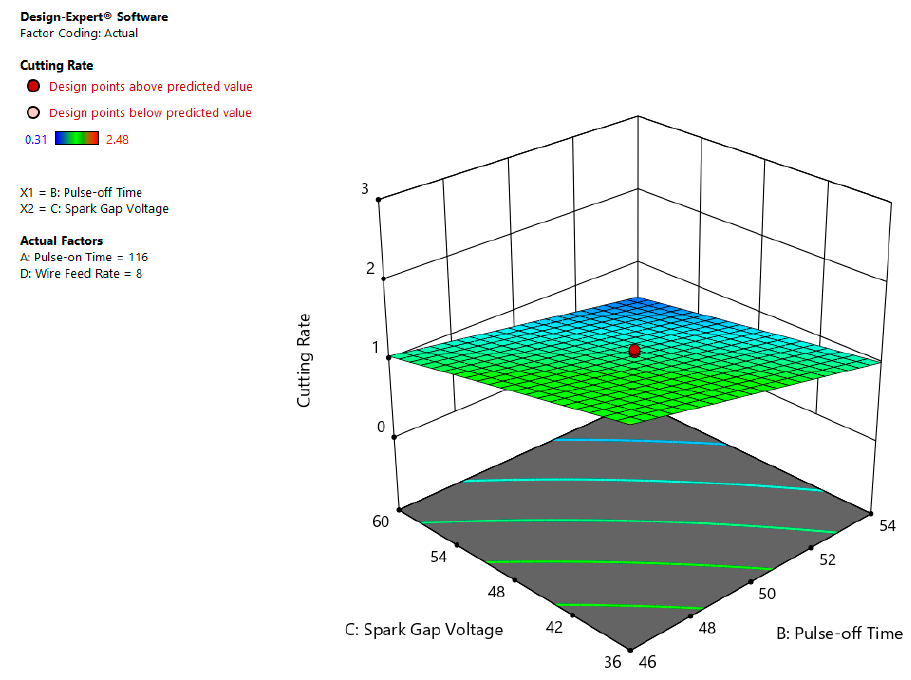
Figure 8. Correlational effect of Toff and SV on CR. Table 6. ANOVA test results for SR.